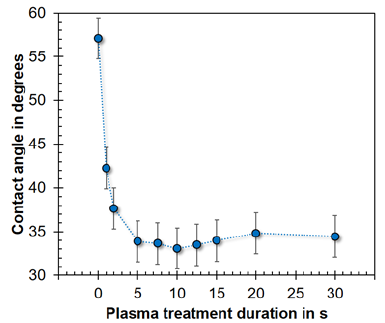
Figure 4. Contact angle of diiodmethane on silicon dioxide surfaces vs. direct dielectric barrier discharge plasma treatment duration using helium as process